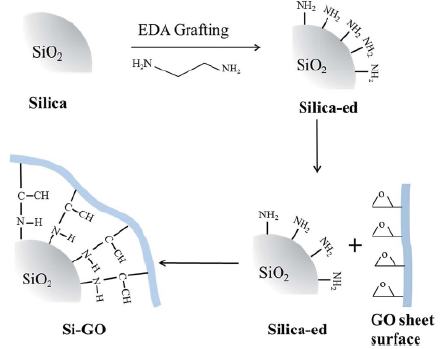
Scheme 3. Schematic diagram of the synthetic route of GO-coated silica [68].